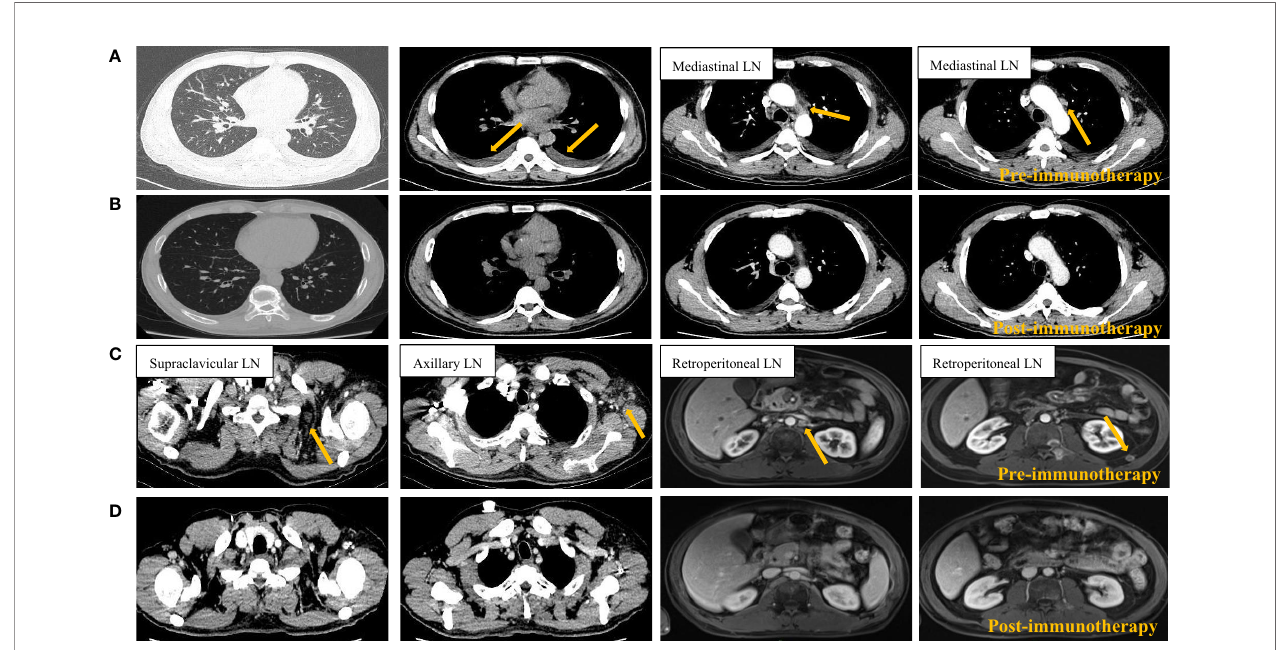
FIGURE 4 | Radiological imaging of the tumors before (A, C) and after (B, D) 1 cycle of PD-1 blockade. Pre-immunotherapy tumor site indicated by orange arrow. LN, lymph